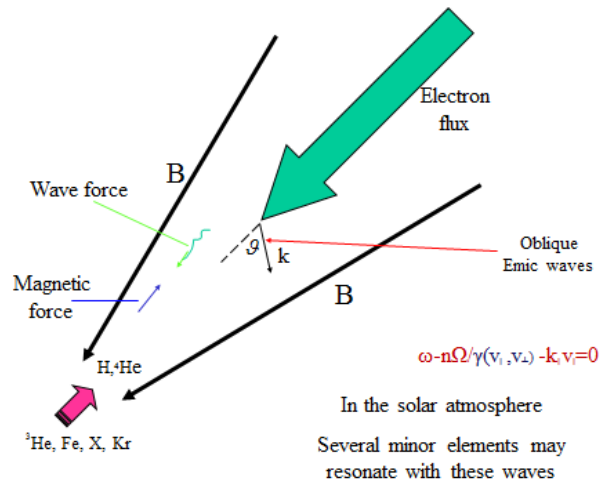
Fig. 2. Sketch of the acceleration process. Oblique waves, supported by H and 4 He, interact resonantly with minority ions: 3 He and se- lected heavy ions; when the wave force balances the magnetic mir- ror force, the ion is efficiently energized. Correlation between 3 He and heavy ions (Fe) may occur only for powerful flares, when the wave amplitude becomes intense, to compensate and balance the mirror